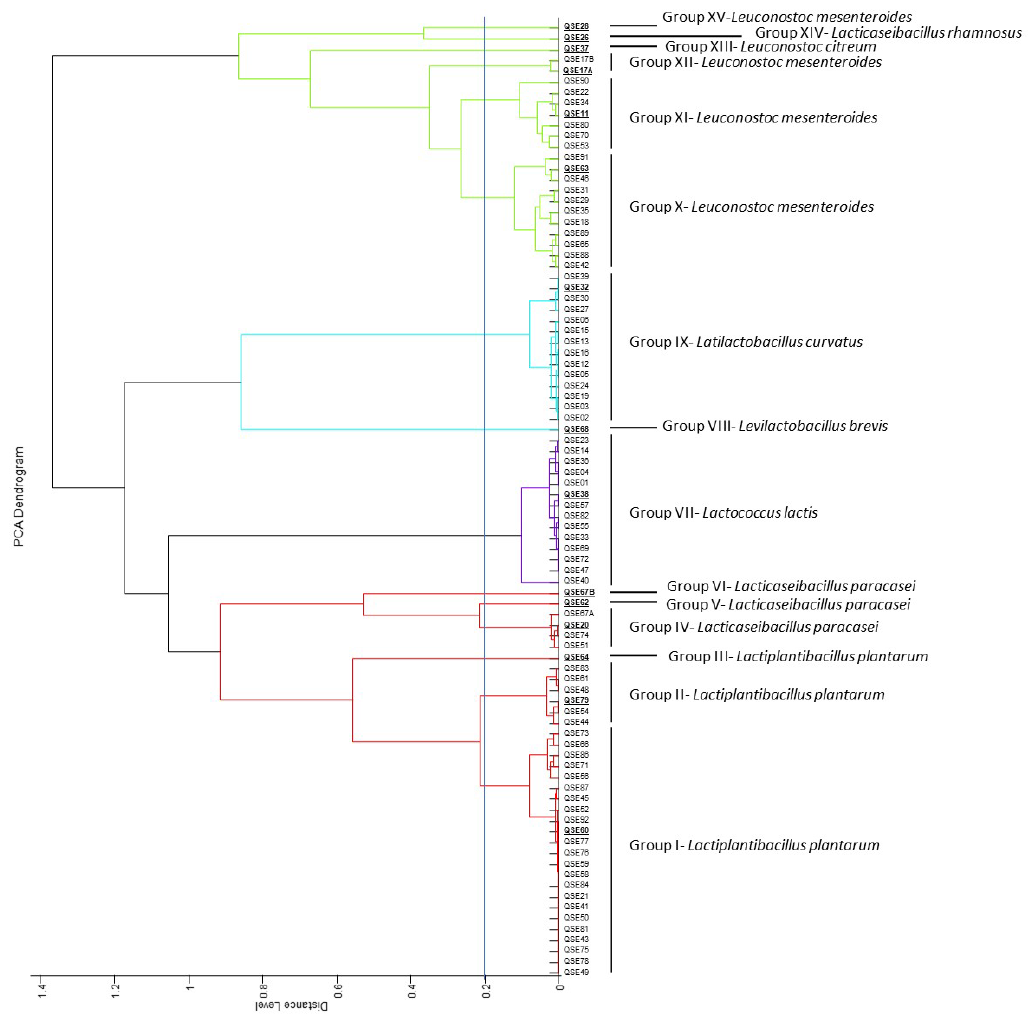
Figure 1. Cluster analysis of MALDI-TOF MS spectra of strains isolated in this study. Distance is displayed in relative units. Representative strains of each group selected for pheS gene analysis are marked in bold.